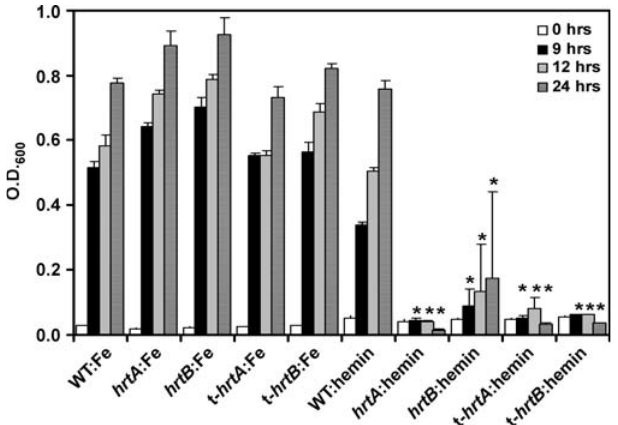
Figure 2. The Hrt System Is Required for Staphyloccocal Growth in Hemin S. aureus Newman (WT), SAV2359 mutant (hrtA), SAV2360 mutant (hrtB), transduced SAV2359 mutant ( t- hrtA), and transduced SAV2360 mutant ( t- hrtB) strains were grown in iron-free medium supplemented with iron (Fe) or with hemin (hemin). Bacterial growth was determined by measuring the optical density (O.D. 600 ) of cultures. Results represent the mean 6 SD from triplicate determinations. Asterisks denote statistically significant differences from wild-type as determined by a Student’s t -test ( p ,